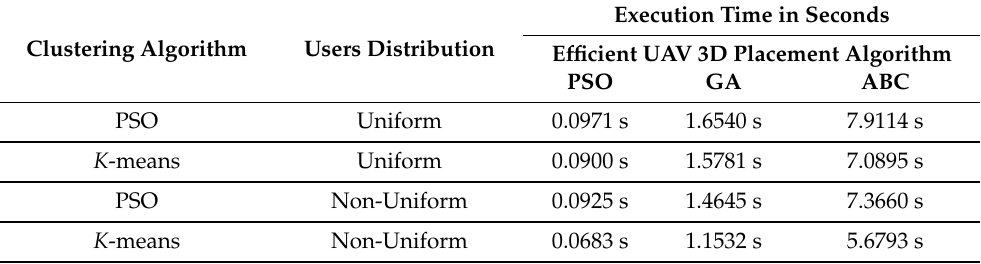
Table 6. Execution time for the power-efficient